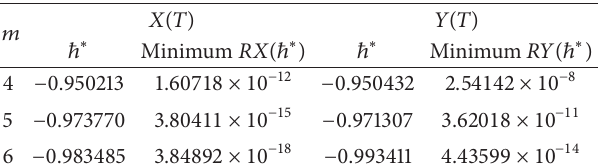
Table 3: The minimum values of 𝑅𝑋(ℏ ∗ ) and 𝑅𝑌(ℏ ∗ ) for various orders of approximations.